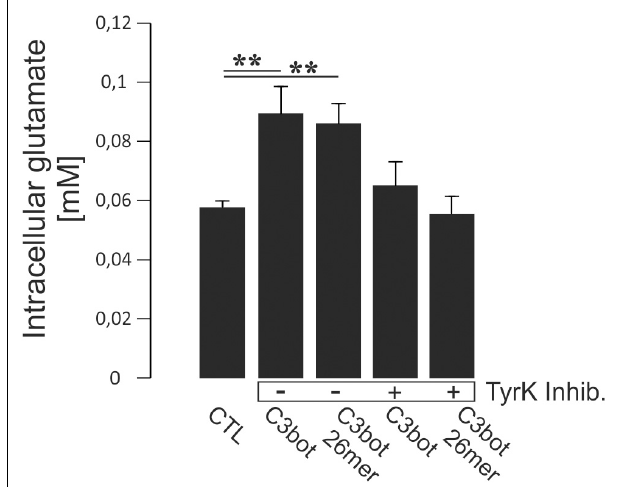
FIGURE 6 | Hippocampal neurons grown for 14 days in culture were incubated with 300 nM of C3bot or C3bot 26mer for additional 3 days with or without the addition of the tyrosine kinase inhibitors Dasatinib (200 nM) and Genistein (20 µ M). Cells were then incubated with 50 µ M of unlabeled glutamate for 1 h. Prior to the uptake, cells were preincubated with dihydrokainate (DHK, 1 mM for 30 min) to selectively block EAAT2 transport activity. After washing, cells were lysed and intracellular glutamate concentrations were analyzed fluorometrically and adjusted to protein content of each individual well. Neurons incubated with C3bot or C3bot 26mer showed intracellular glutamate concentrations enhanced by 53 and 46%, respectively. These effects were blocked in the presence of tyrosine kinase inhibitors. Values (analyzed in quadruplicates) are PDC- and DHK-sensitive and were calculated from fluorescence units and glutamate standards expressed as means ± SEM from 2 independent experiments. ** p ≤